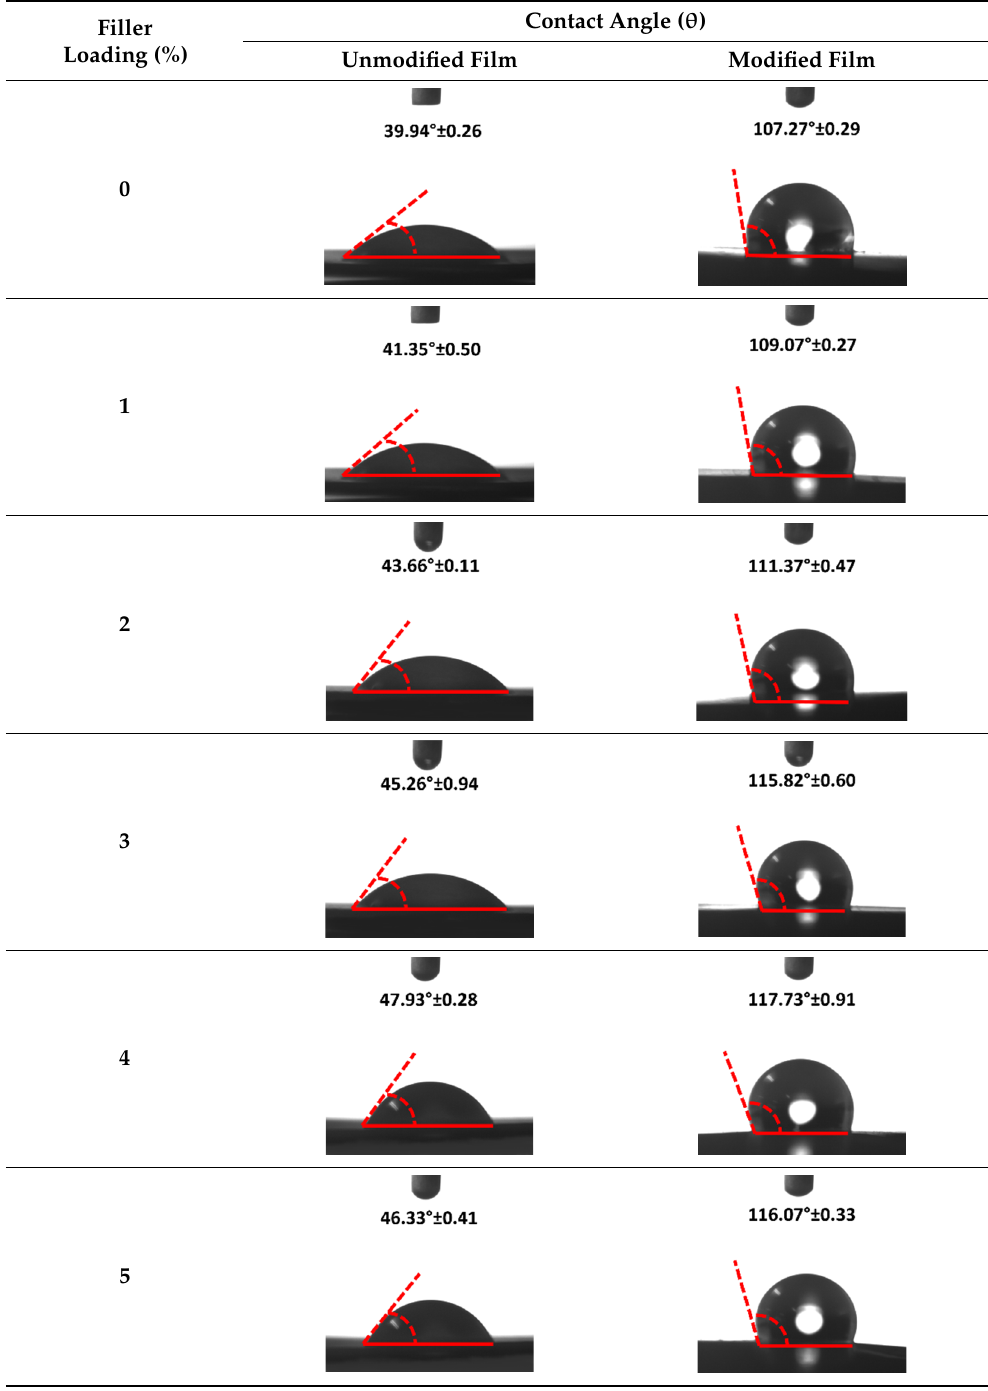
Table 1. Droplet images and contact angles ( ◦ ) of seaweed/CNF composite film.